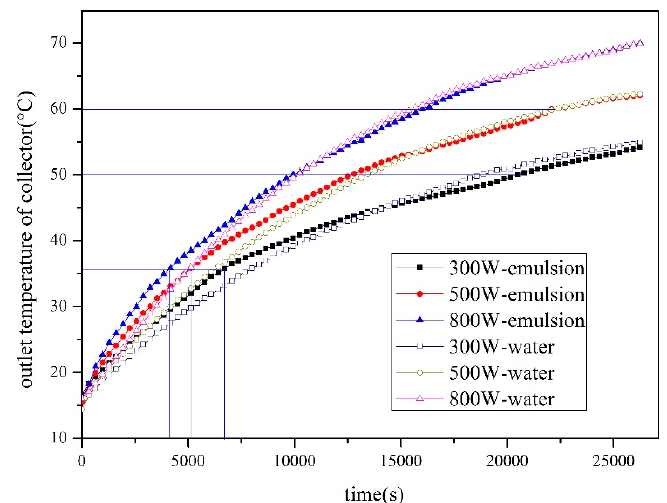
Figure 9. Outlet temperature of the solar collector under different radiations.